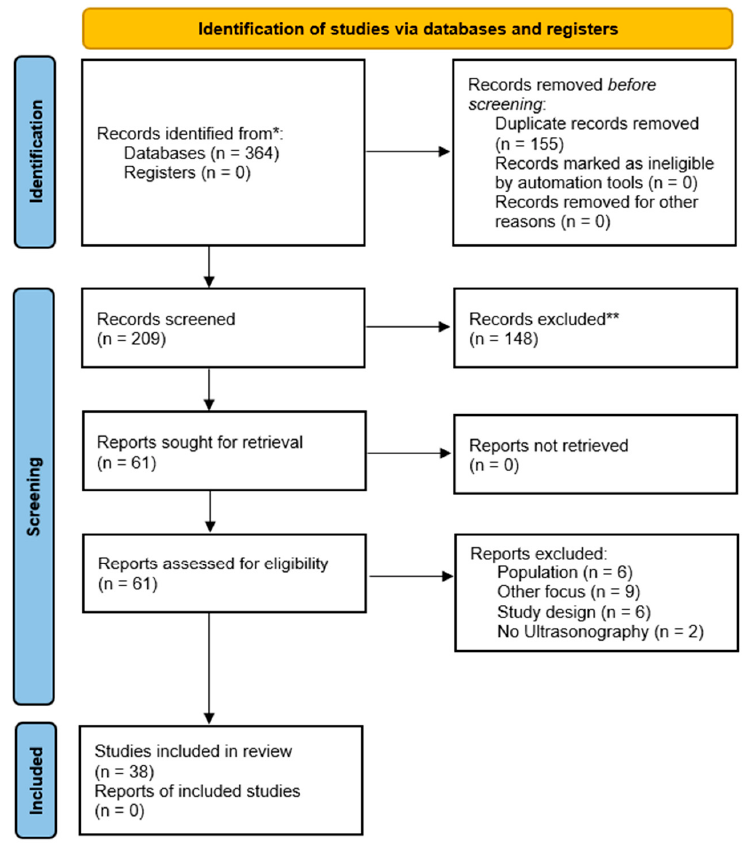
Figure 1. PRISMA flow chart. * PubMed: 65; Scopus: 135; Web of Science: 164. ** manually